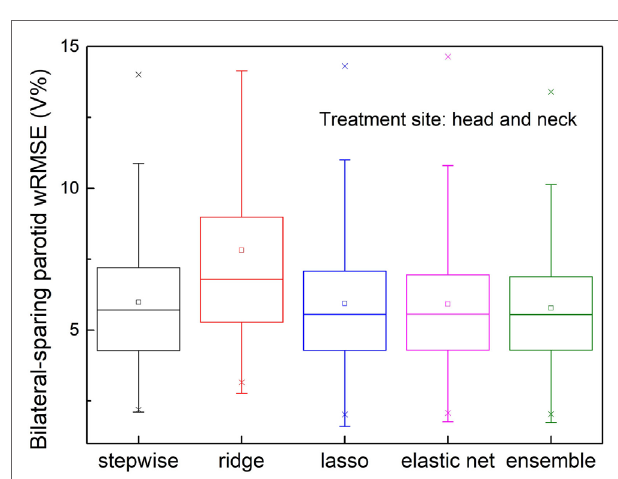
FigUre 7 | Prediction errors [Weighted root mean squared error (wRMSE)] of individual regression models and the proposed ensemble models for parotid dose volume histogram (DVH) prediction of bilateral parotid-sparing cases. Training set includes 80 bilateral sparing cases and 10 single-side sparing cases. Validation set includes 148 bilateral sparing cases. The proposed ensemble model yields significantly reduced prediction error than stepwise ( p = 0.026) and ridge ( p < 0.001), but does not outperform elastic net ( p = 0.090) or lasso ( p =